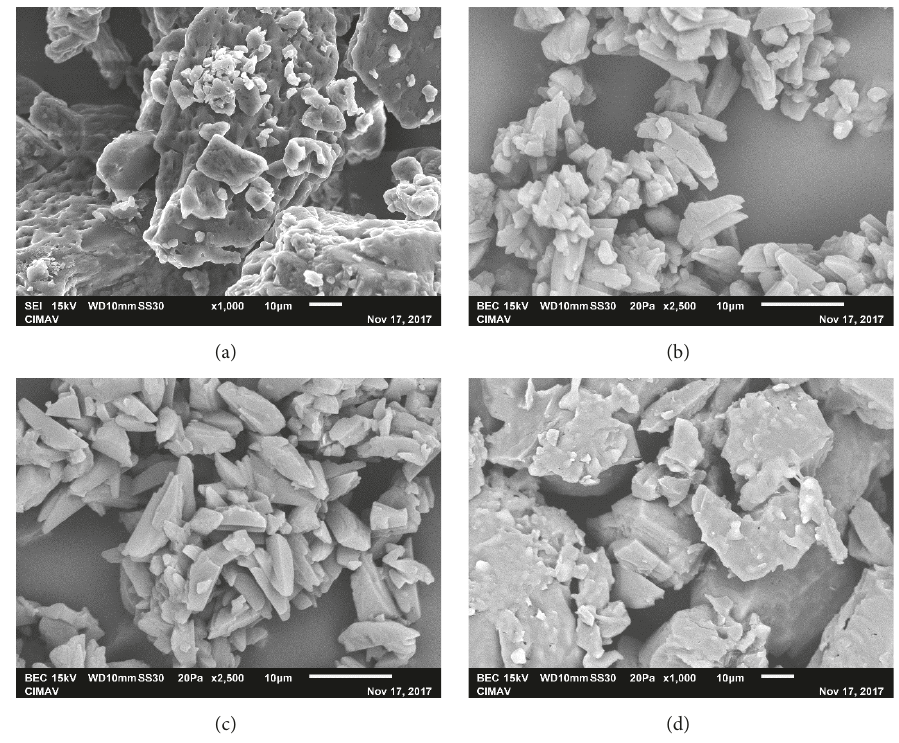
Figure 7: SEM micrographs of the samples prepared at (a) 27, (b) 29, (c) 31, and (d) 32 ∘